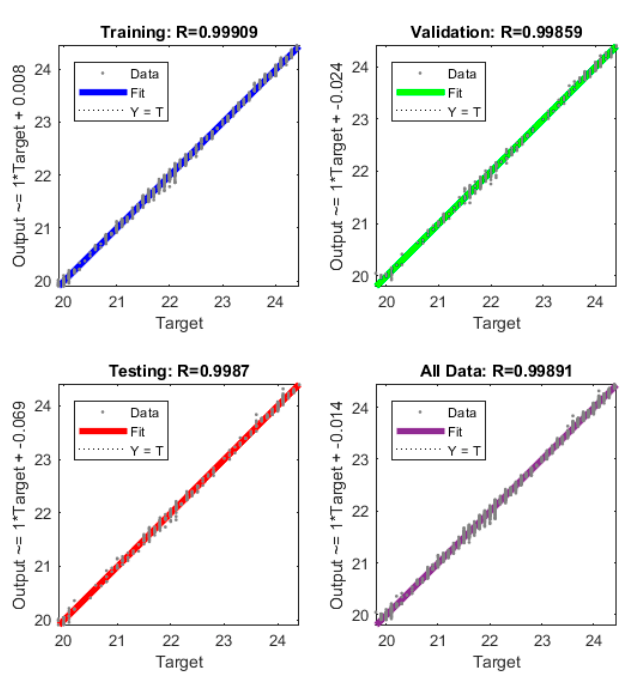
Figure 14. Correlation plots between the network’s outputs and targets for all learning stages separately and combined, obtained for the best analyzed neural network.